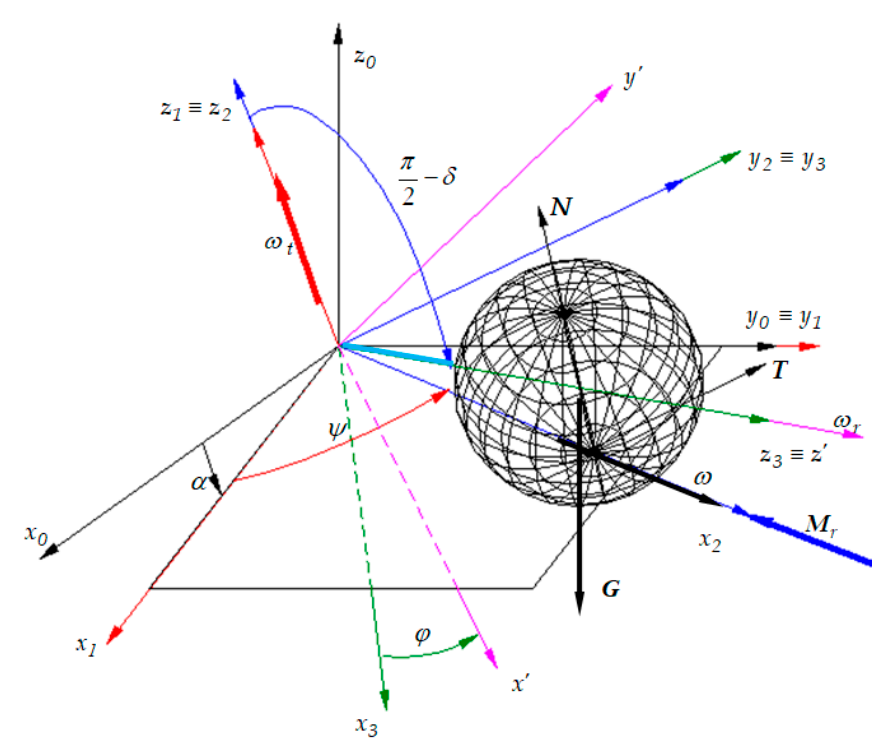
Figure 6. The reference systems used for the model.